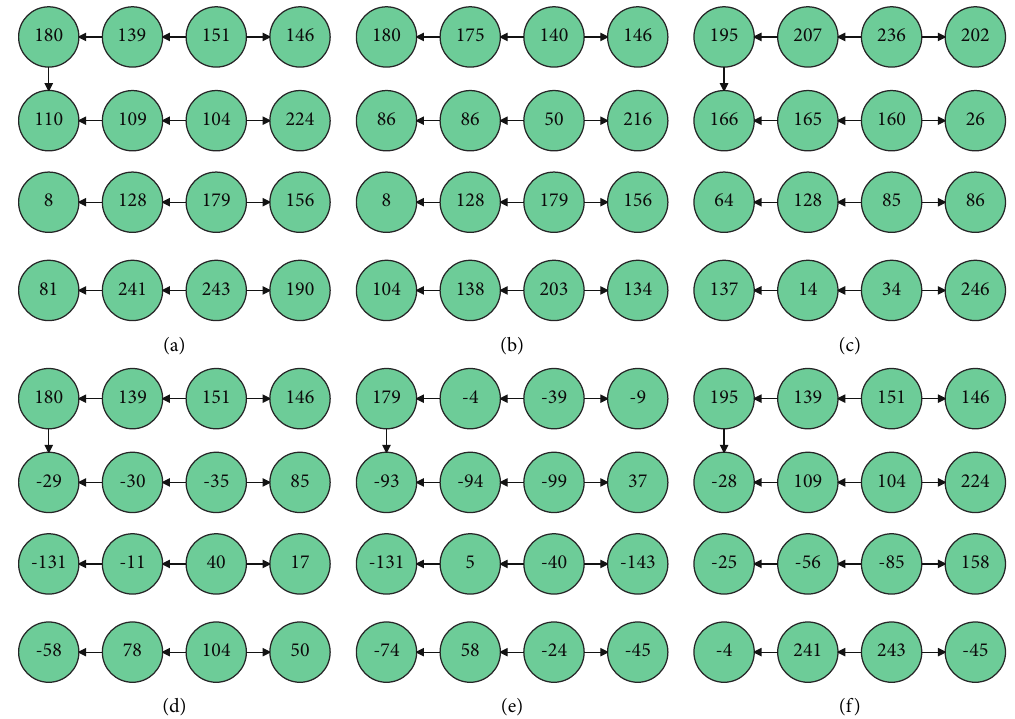
Figure 3: Comparison of the relevance of encryption methods. (a) The original image block. (b) Encrypted image block. (c) Mod 256 encryption image block. (d) The original image block D-value. (e) Encrypted image block D-value. (f) Mod 256 encryption image block D-